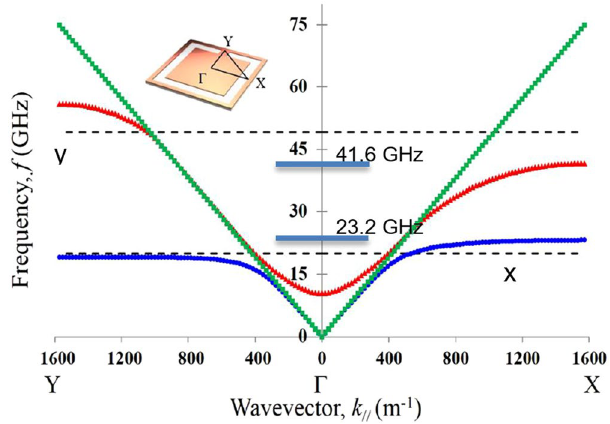
Figure 4. Model dispersion for the eigenmodes of the FEM model, plotted in the first Brillouin Zone. The lower mode in blue is the first order antisymmetric mode giving the 20.00 GHz x-direction beaming. The mode shown in red is the second order antisymmetric mode giving the 49.15 GHz y-direction beaming. The green points are the first order, isotropic, symmetric mode. Dashed lines show the positions of the lower (20.00 GHz, x-beaming) and higher (49.15 GHz, y-beaming) beaming frequencies. The lowest two mode resonant frequencies are indicated by the horizontal blue lines.